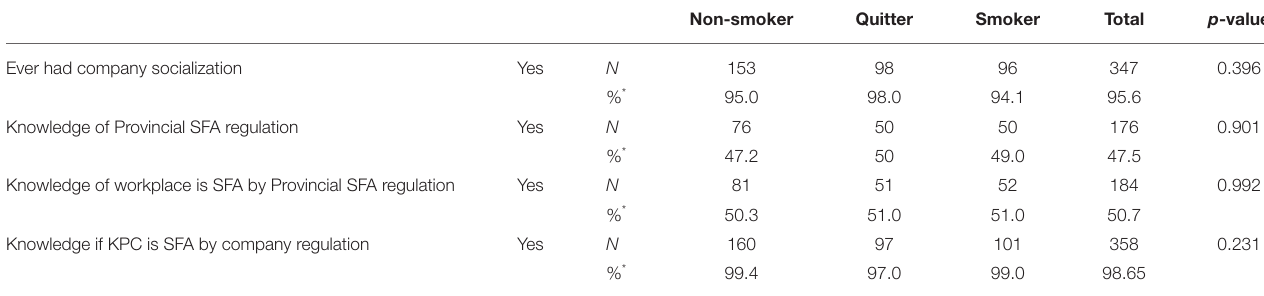
TABLE 2 | Knowledge about smoke-free